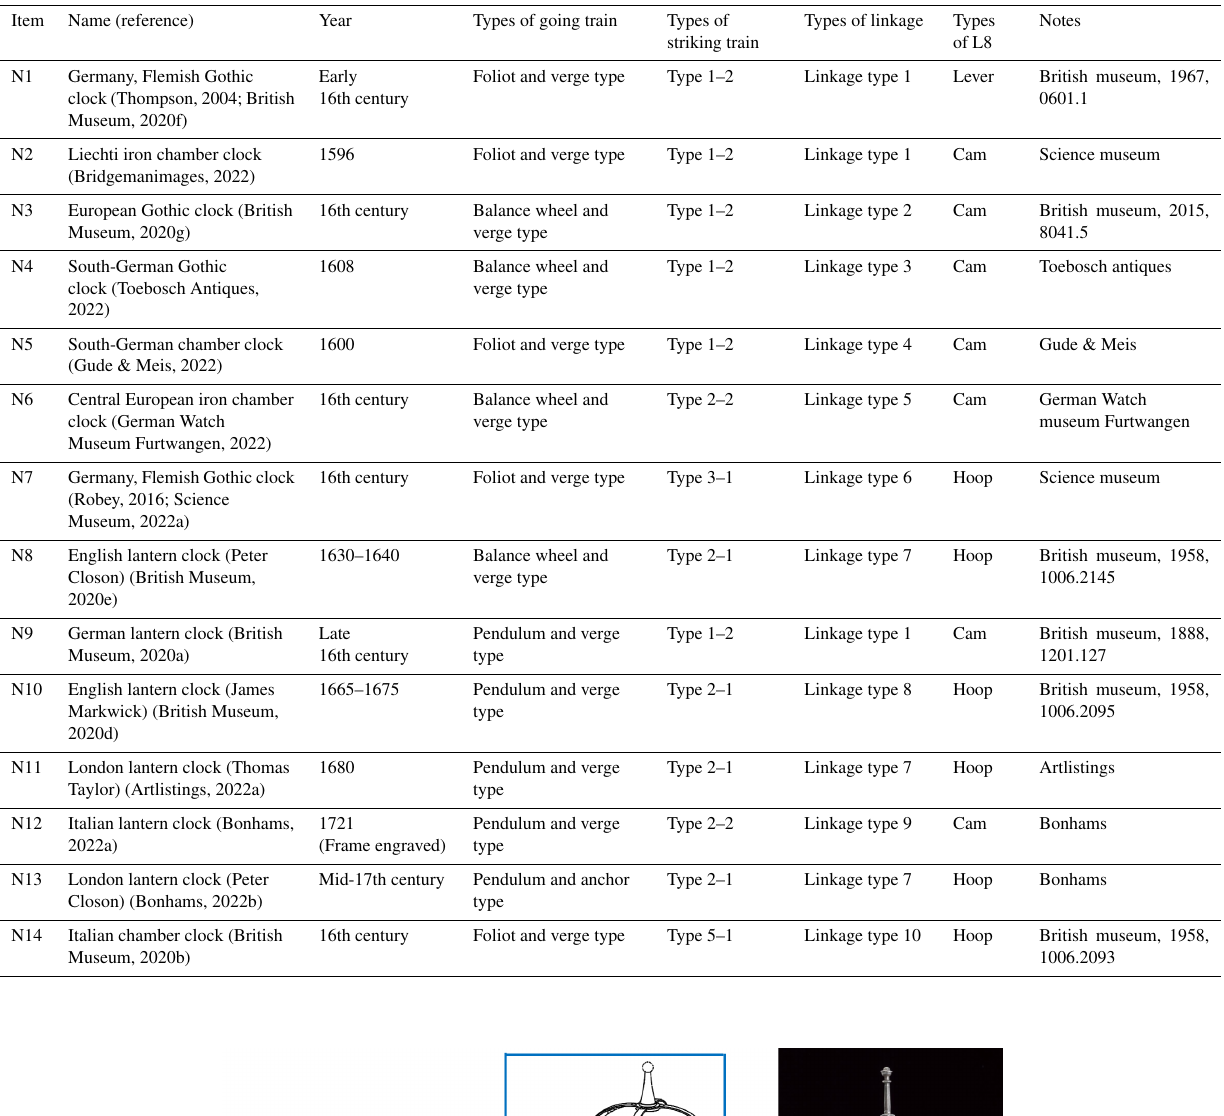
Table 1. Mechanisms and configurations of the 14 existing representative chamber clocks. (The indicated year of production does not represent the year the configuration was developed. The order in which the clocks are presented also does not indicate the evolutionary order.)